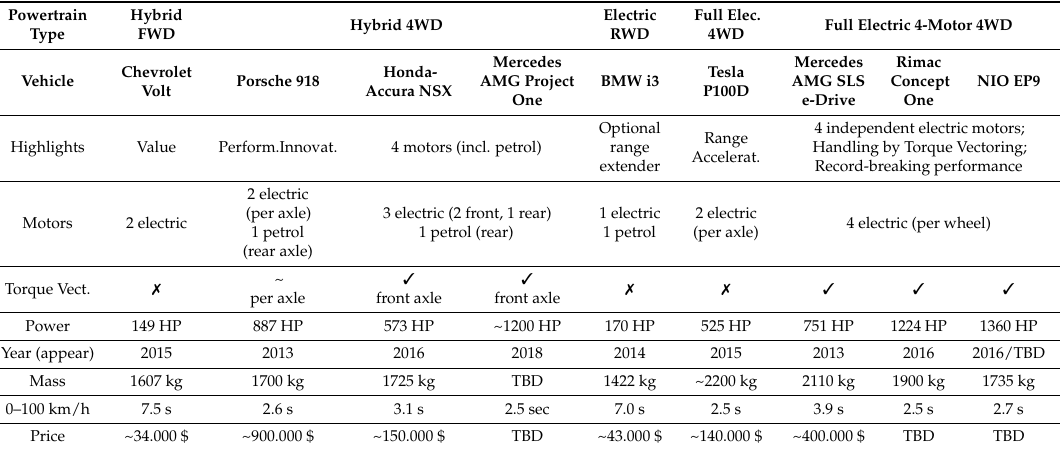
Table 1. Overview of some relevant multi-motor vehicles